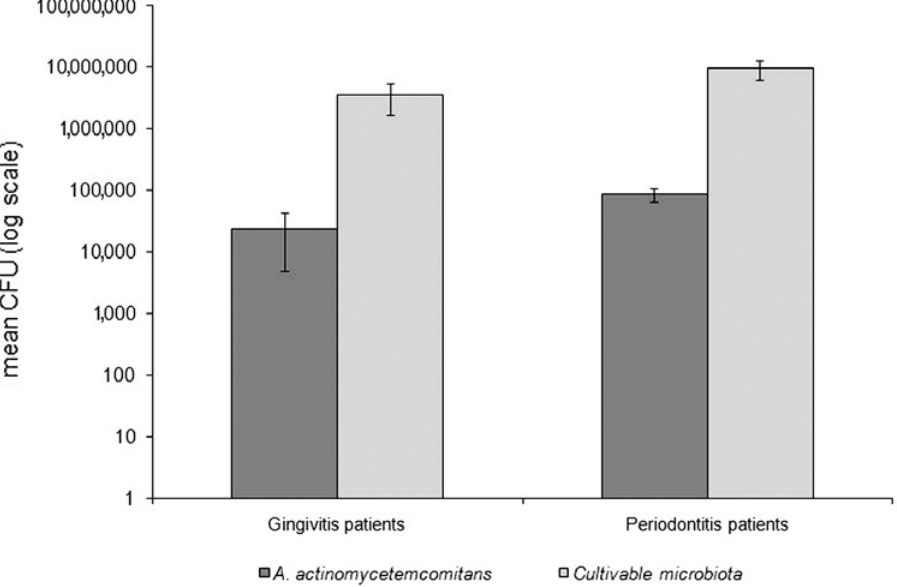
FIGURE 2- Occurrence of Aggregatibacter actinomycetemcomitans in subgingival biofilm from Brazilian Indians evaluated by